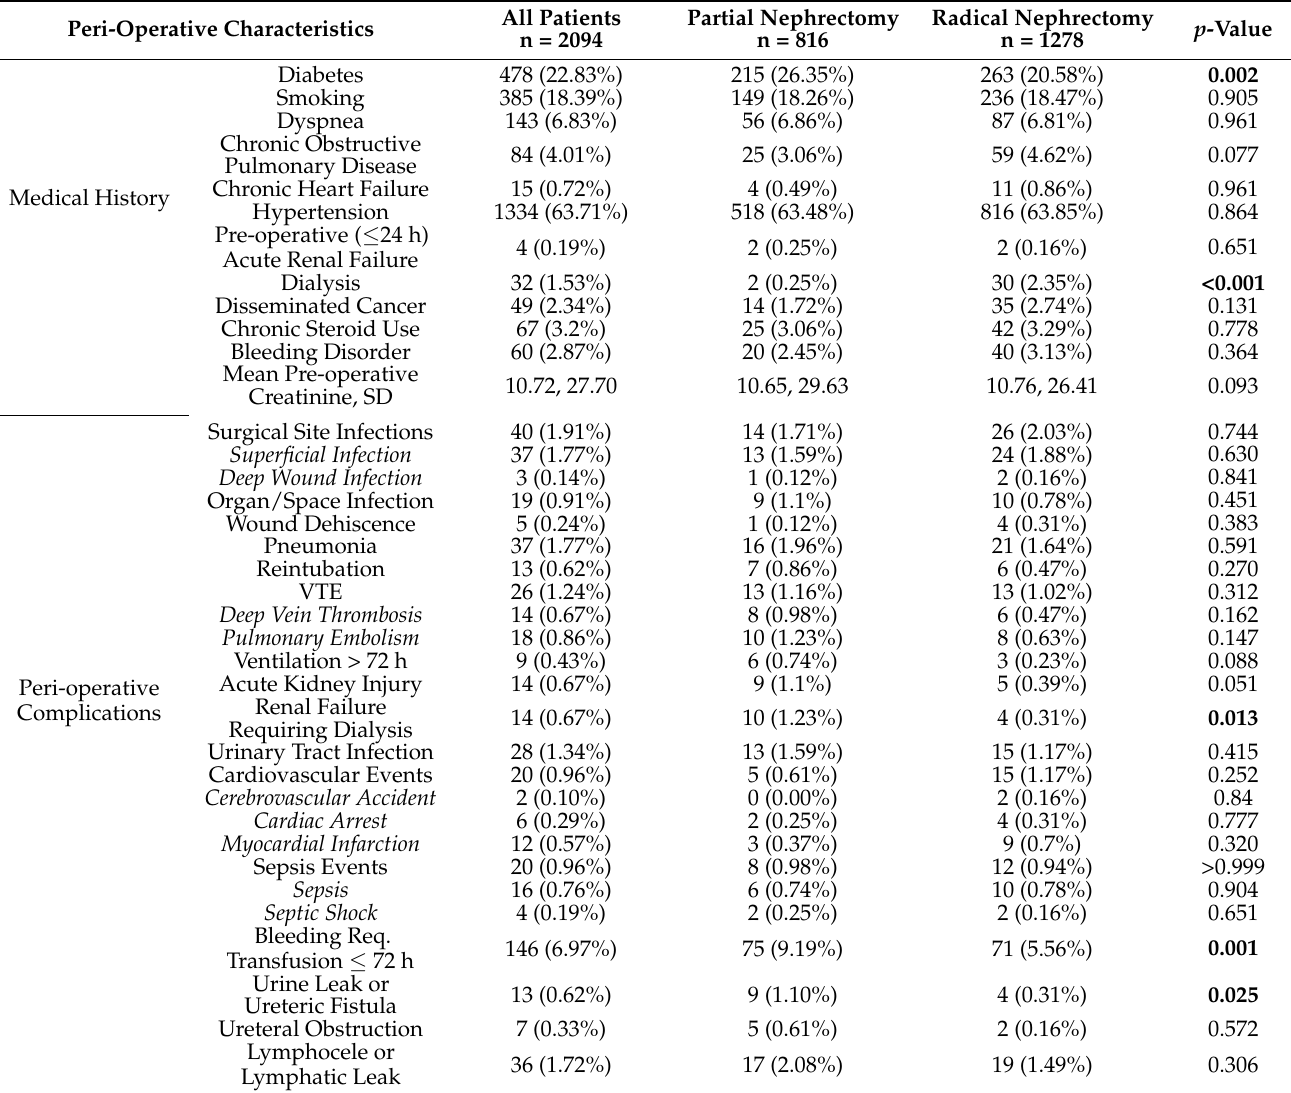
Table 2. Patient comorbidities and peri-operative complications stratified by partial versus radi- cal